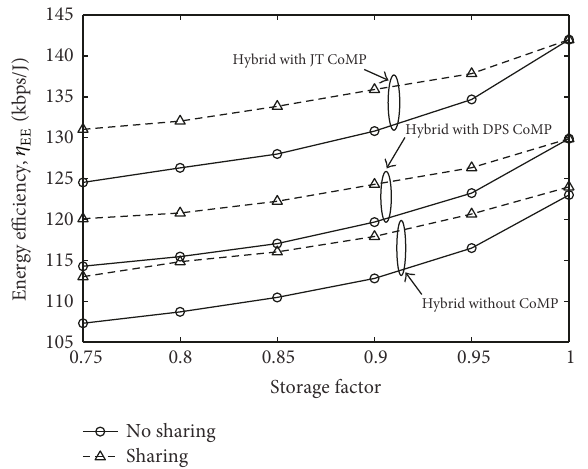
Figure 14: EE with storage factor for di ff erent hybrid scenarios with energy sharing under varying solar capacity.